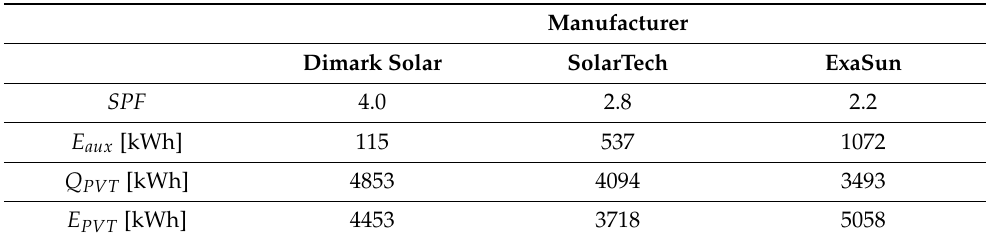
Table 14. System performance for the different PVT collectors manufactured by Dimark Solar, SolarTech and ExaSun. The collector area is 25 m 2